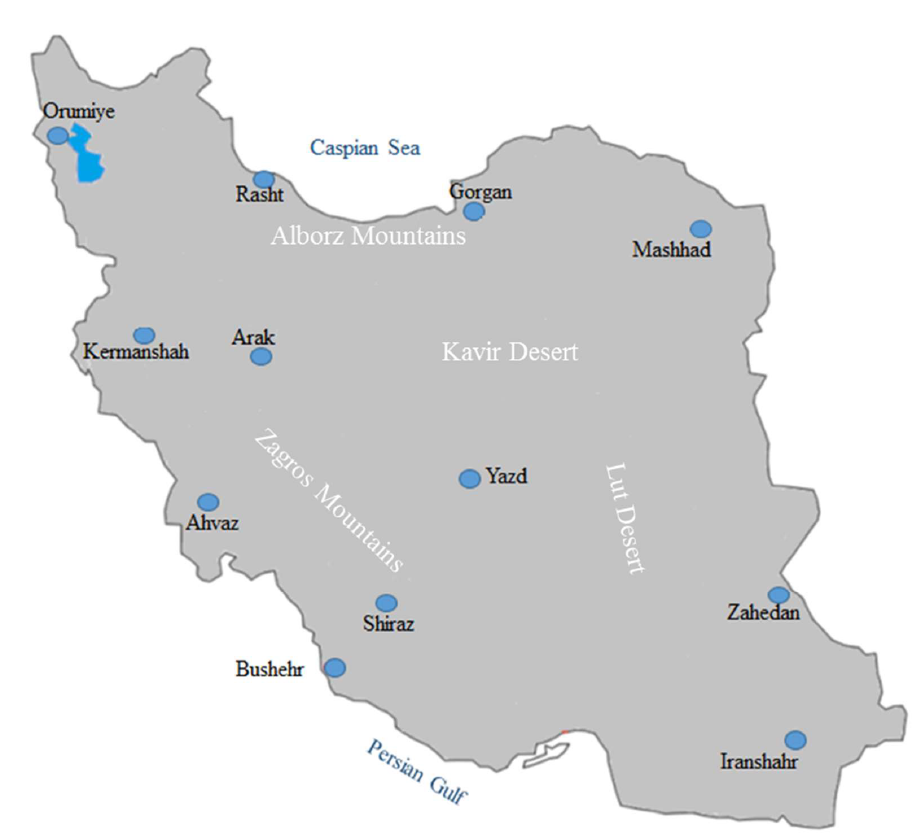
Figure 1. Location of the synoptic stations which are considered in this study.